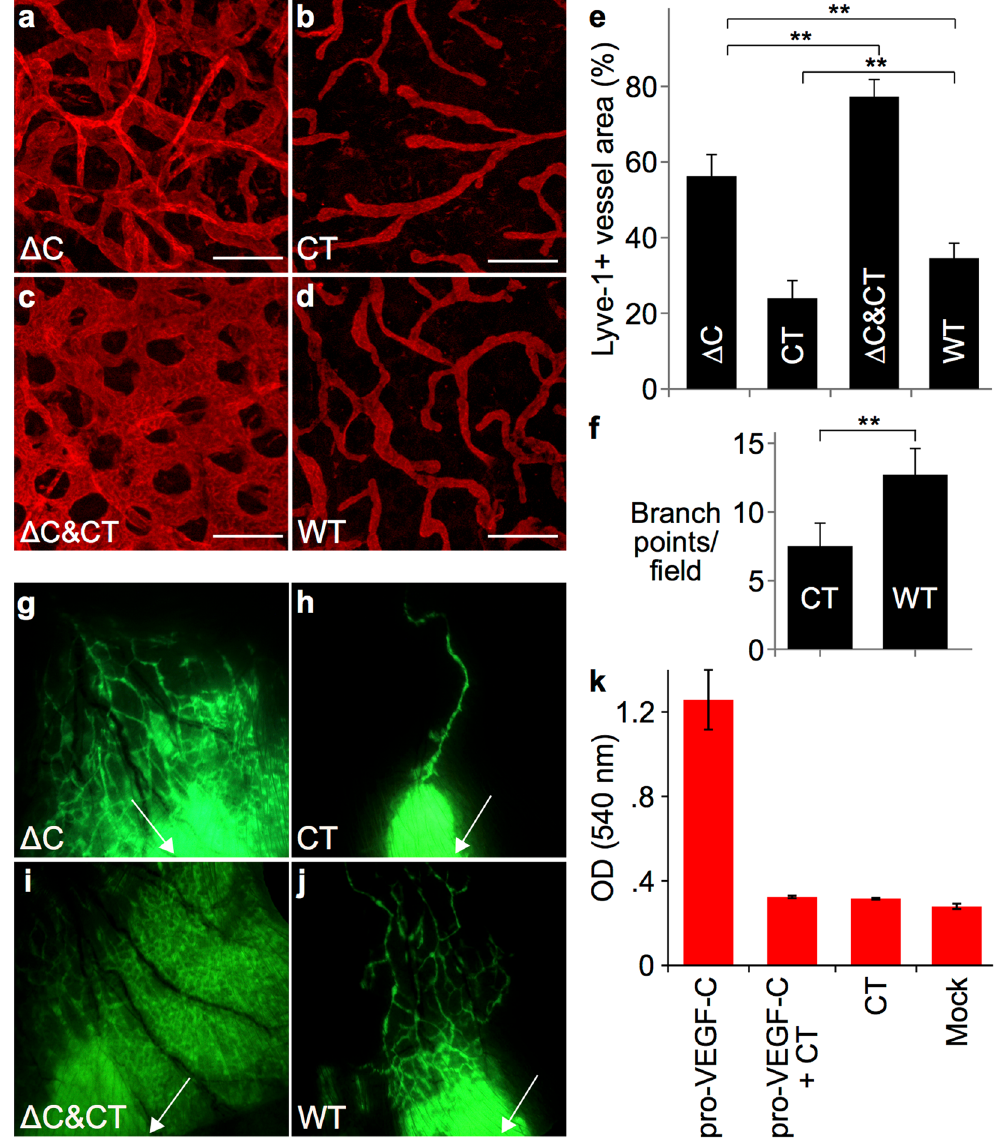
Figure 2. The C-terminus of VEGF-C enhances the lymphangiogenic response to VEGF-C, but represses lymphangiogenesis on its own. Lyve-1 whole-mount immunofluorescent stainings of ear skin from K14-VEGF- C- Δ C ( a ), K14-VEGF-C-CT ( b ), K14-VEGF-C- Δ C x K14-VEGF-C-CT ( c ) and wild type (WT) littermate ( d ) mice. ( e ) Quantification of Lyve-1-positive area in the whole-mount stained ear skin. ** P < 0.01; n ≥ 4; Scale bar: 150 μ m. ( f ) Quantification of branch points of Lyve-1-positive vessels per field. ** P < 0.01; n ≥ 4. ( g – j ) Fluorescent microlymphangiography in the ears of adult mice. The injection site for FITC dextran is indicated by a white arrow. ( k ) Pro-VEGF-C (0.25 µ g/ml) induces modest survival of Ba/F3-hVEGFR-3/EpoR cells, likely mediated by endogenous proteases. However, the addition of VEGF-C-CT (0.6 μ g/ml, 10-fold molar excess) efficiently suppresses the survival mediated by